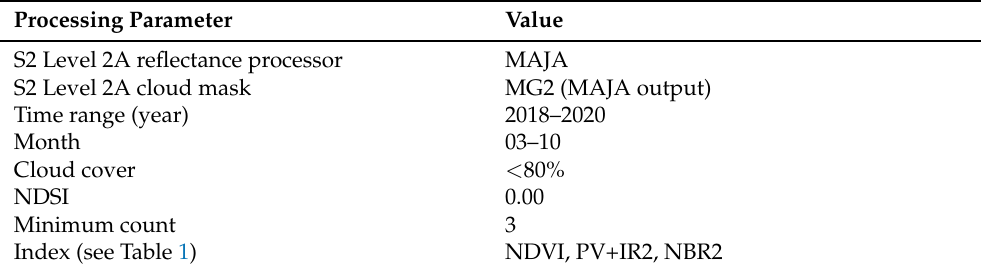
Table 2. Soil reflectance composite (SRC) processing parameter settings. Processing